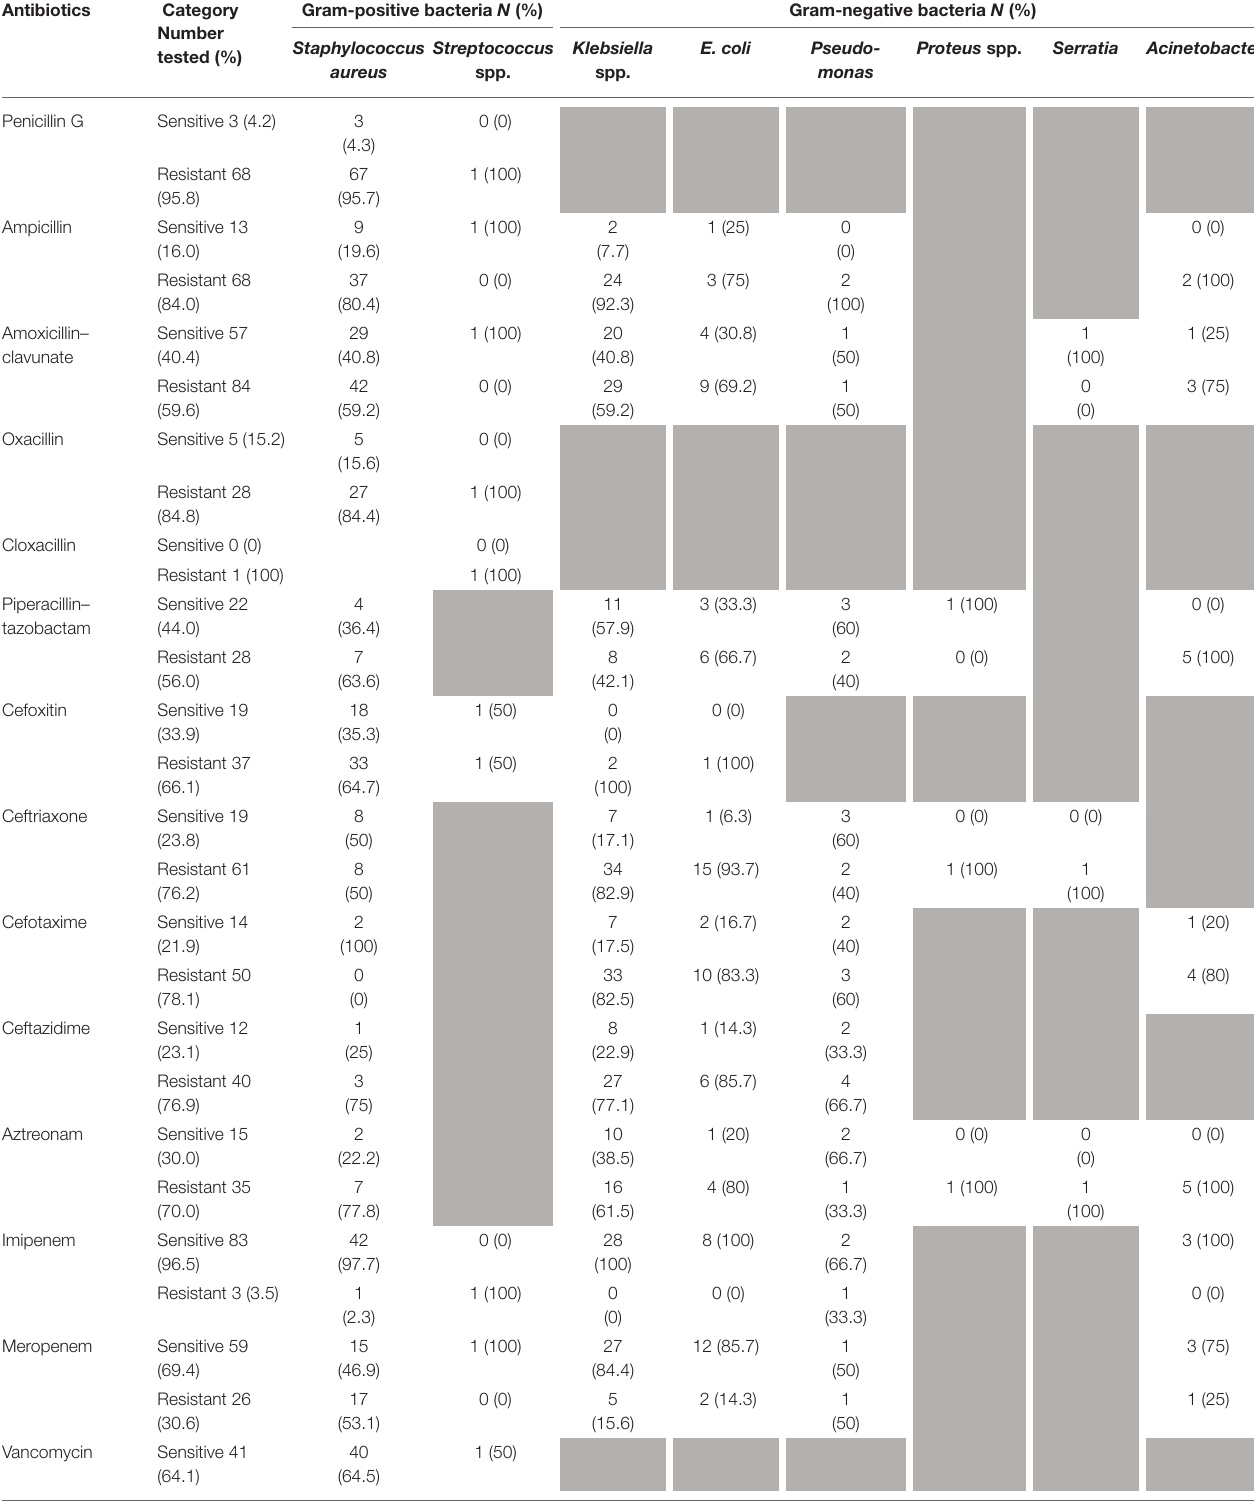
TABLE 7 | Antibiotic susceptibility and resistance pattern of isolated organisms. Antibiotics Category